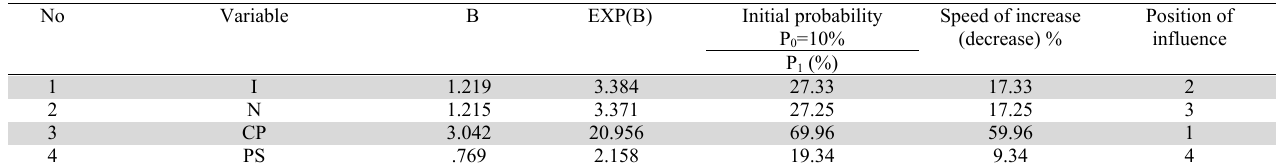
The influence of